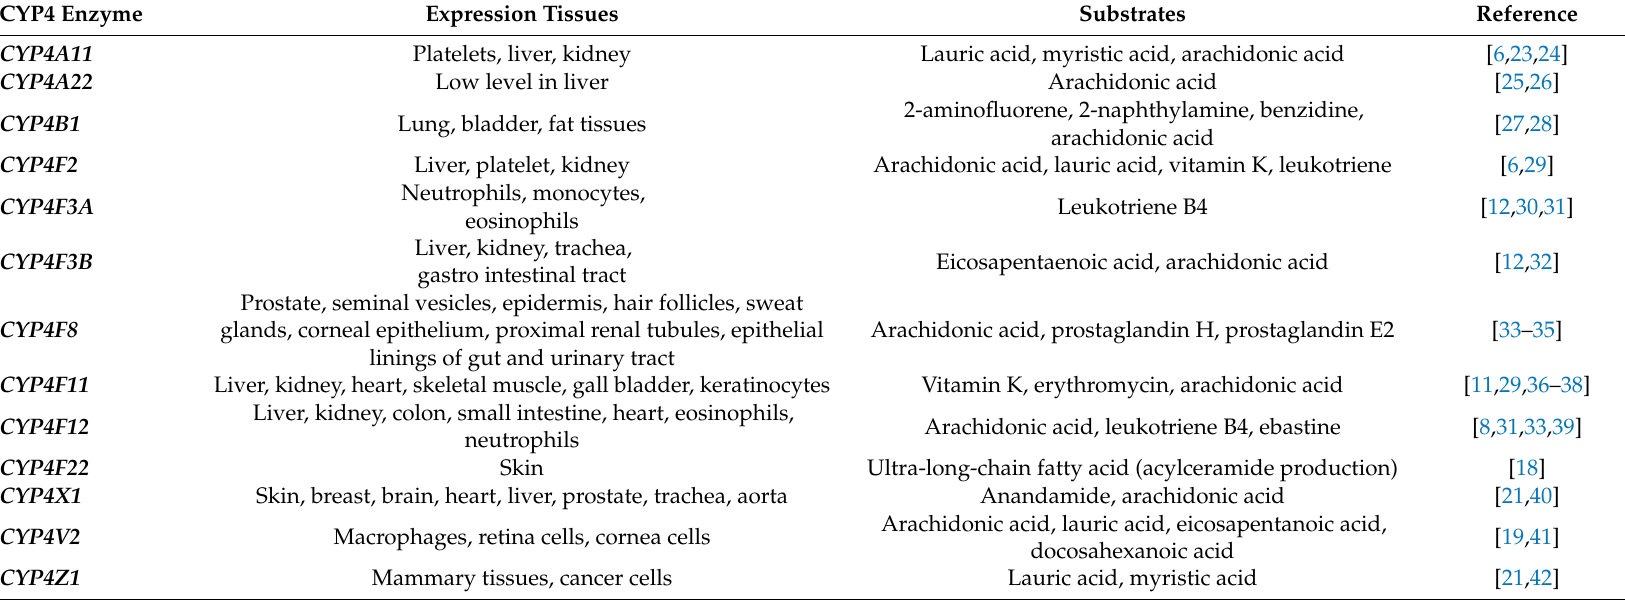
Table 1. Substrates and major expression tissues of cytochrome P450 4 (CYP4) enzymes in